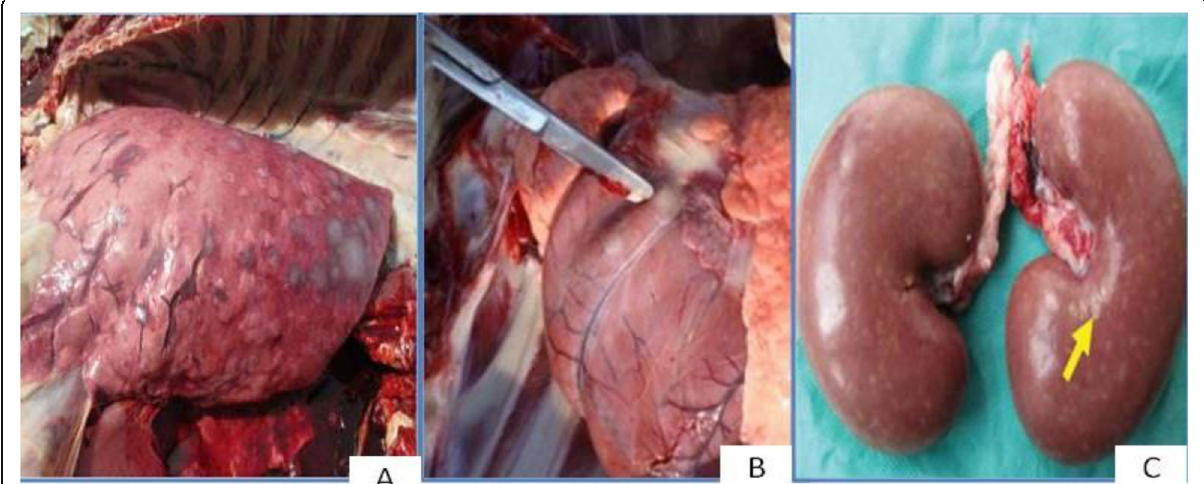
Fig. 3 Pox lesions in A the lung, B heart muscles and C kidney. Source (Courtesy: photograph Colin